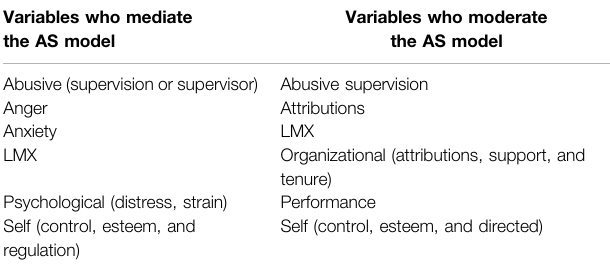
TABLE 2 | Most frequent variables identi fi ed as mediating/moderating